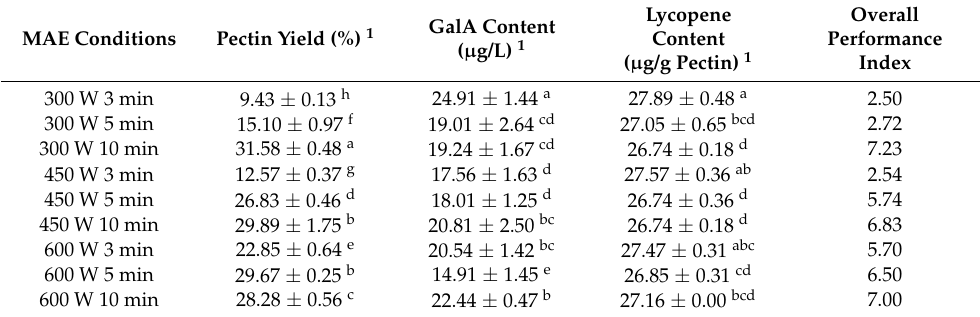
performance index of each MAE